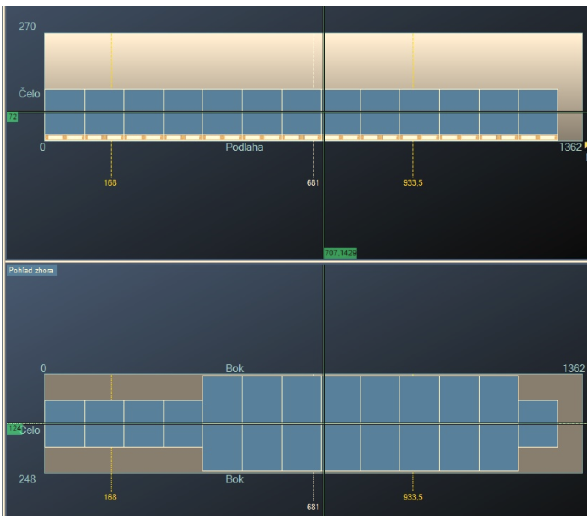
Figure 5: Proposal for distribution of 21 IBC containers on the semi- trailer with payload of 24 t (side and top view) [authors based on Truck Stow and